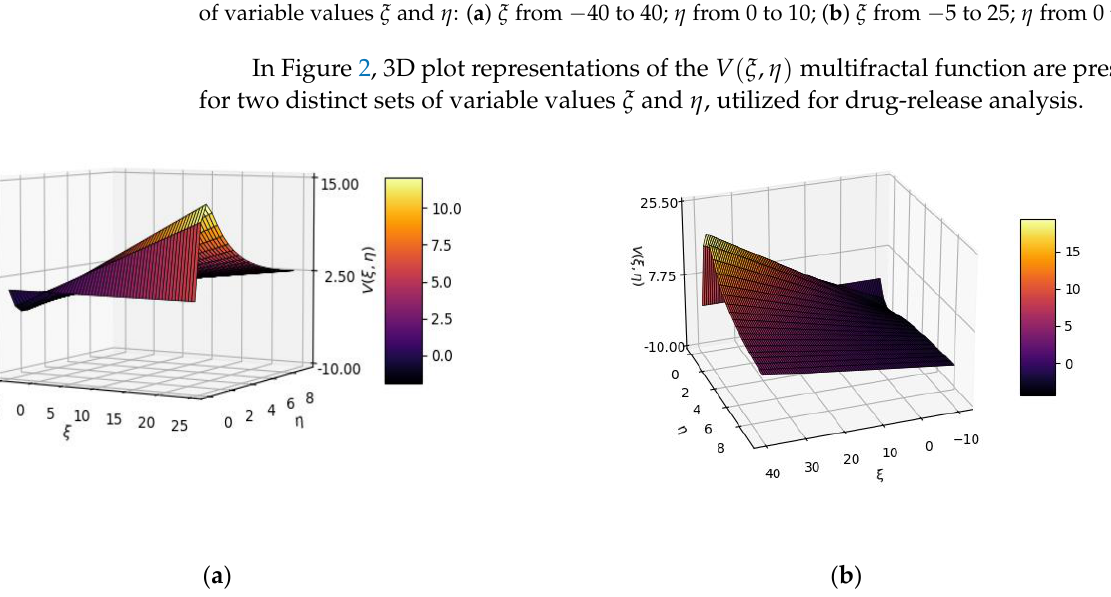
Figure 2. Three-dimensional plot representations of V ( ξ , η ) multifractal function for two distinct sets of variable values ξ and η : ( a ) ξ from − 5 to 25; η from 0 to 10; ( b ) ξ from − 40 to 40; η from 0 to 10.